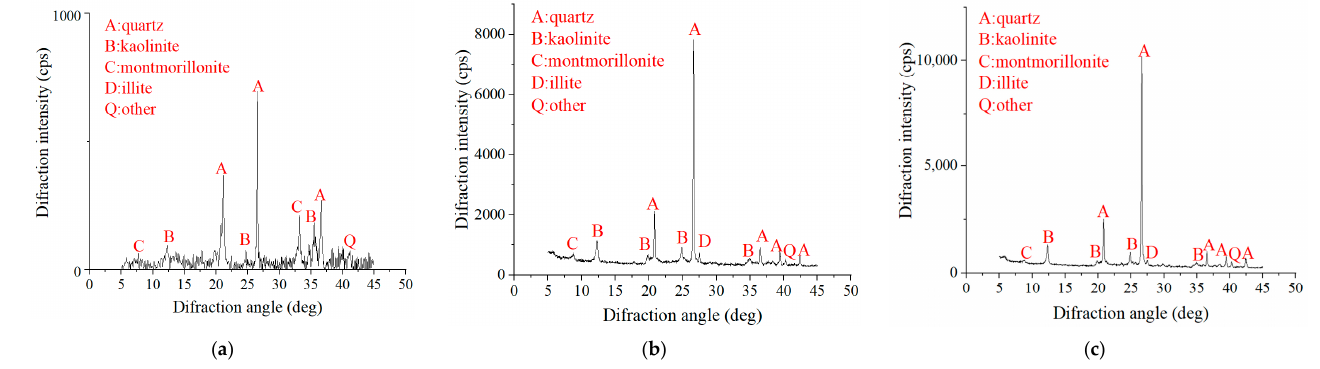
Figure 7. X-ray diffraction patterns of specimens. ( a ) Diffraction results of mudstone; ( b ) Diffraction results of sandy mudstone; ( c ) Diffraction results of sandstone. Table 4. Results of composition analysis in specimens by X-ray.